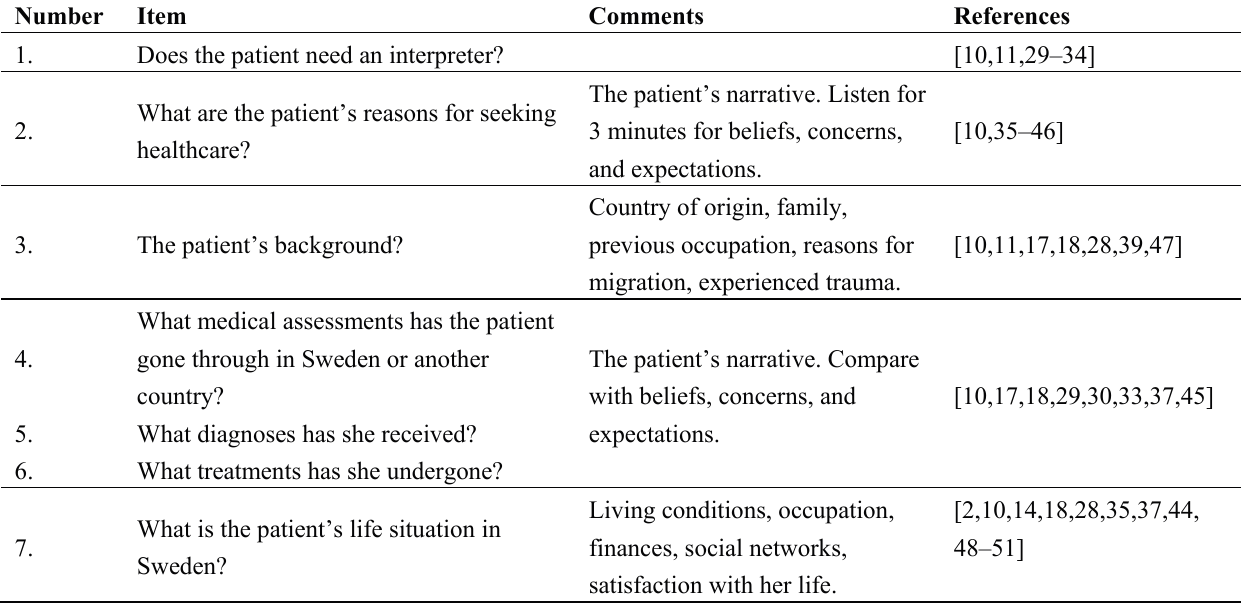
Table 1. The items selected for the interview guide regarding the rehabilitation needs of women from the Middle East suffering from chronic